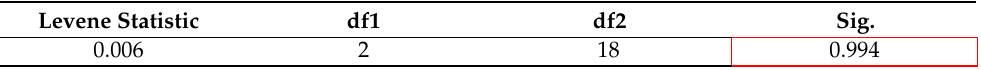
Table 8. Results of the test for equality of variance (prediction success rate of pinch gesture for each